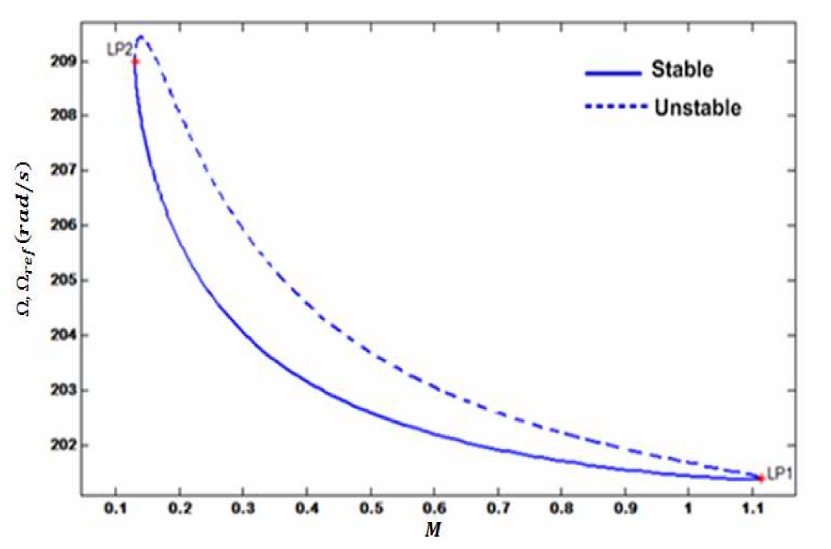
Figure 3. Modulation index bifurcation diagram.